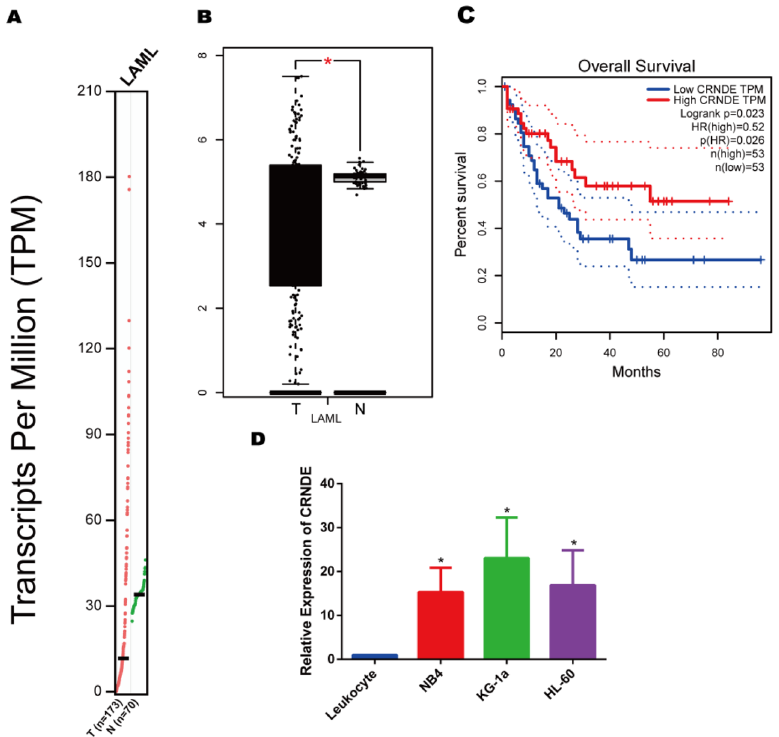
Figure 1. High expression of CRNDE in AML. ( a , b ) The expression of CRNDE in normal samples (n = 70) and AML samples (n = 173) from GEPIA (http:// gepia. cancer- pku. cn/ index. html) analysis. ( c ) The overall survival curves of CRNDE in AML patients from GEPIA analysis. ( d ) CRNDE expression in AML cell lines was detected by qRT-PCR. * p < 0.05, ** p <